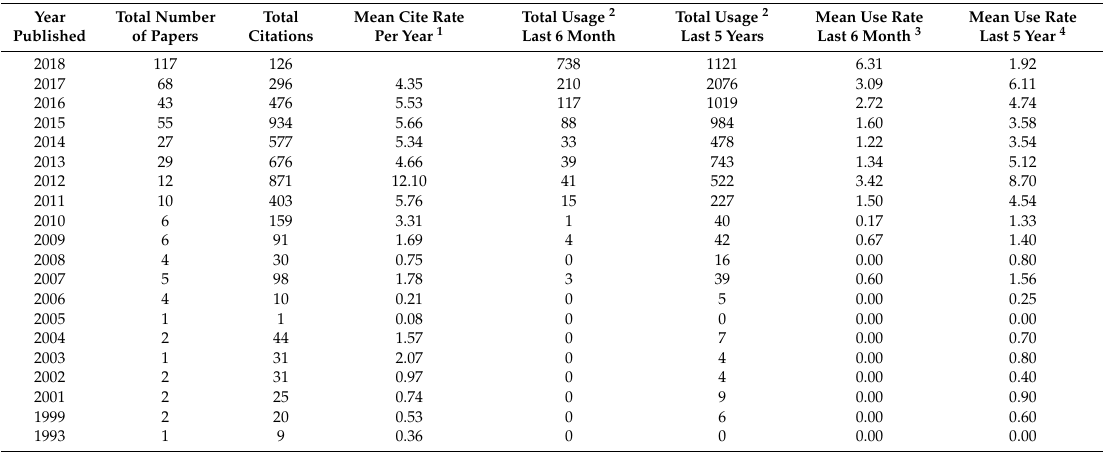
Table 2. General characteristics of